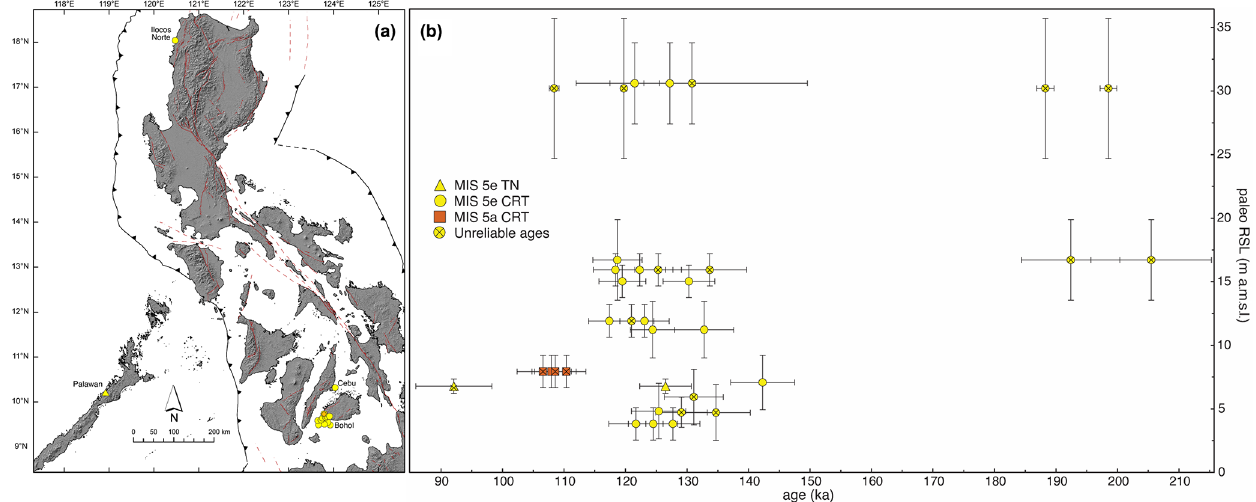
Figure 6. RSL proxies and age–elevation plot of dated corals in the Philippines. (a) Location map of the 15 RSL proxies screened in this study (13 of which from MIS 5e coral reef terraces (CRTs), 1 from MIS 5e tidal notch (TN), and 1 from MIS 5c CRT). Also shown are the names of the study sites mentioned in the original publications. (b) Age–elevation plot of all the 35 coral samples (including unreliable ones) dated using U-Series. Digital elevation model sourced from ASTER GDEM V003 (NASA/METI/AIST/Japan Spacesystems and U.S./Japan ASTER Science Team,